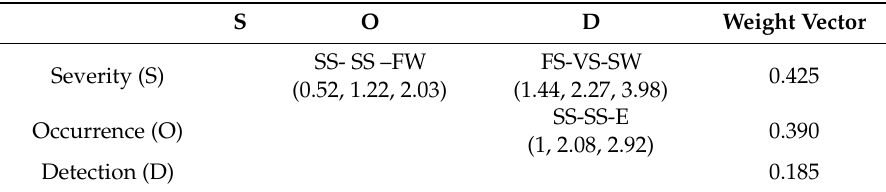
Table 4. Evaluation of experts in the first level of risk assessment